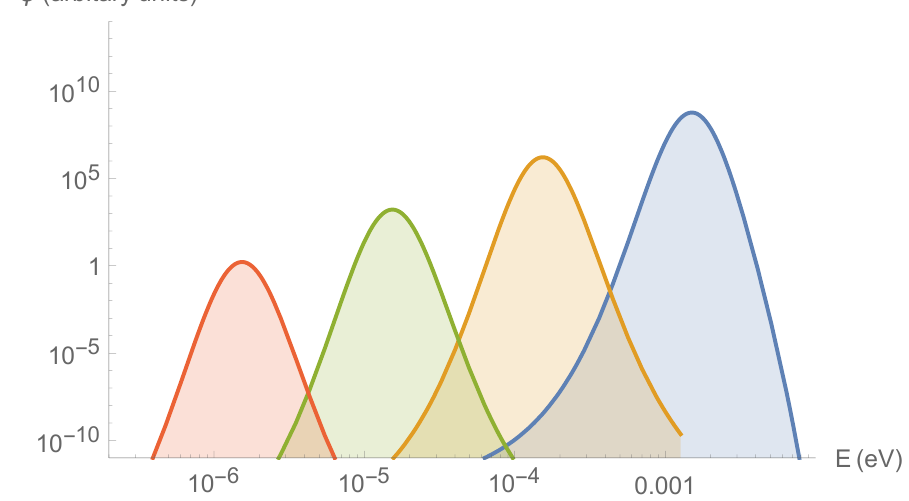
Figure 7. Electromagnetic flux emitted by bouncing BHs for a mean mass M 0 of (from right to left) M t , 10 M t , 100 M t and 1000 M t , normalized such that the total mass going into primordial black H H H H holes (PBHs) is the same. From